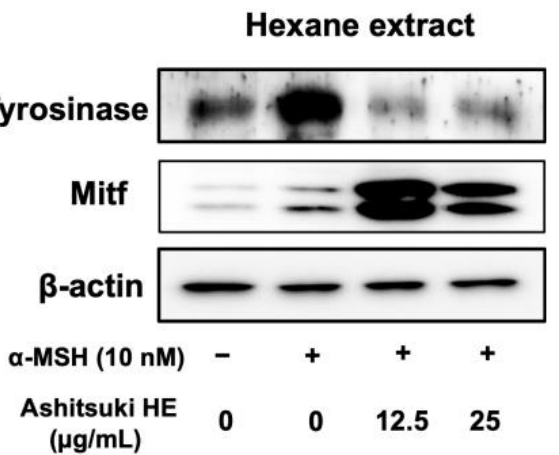
Mitf protein level was upregulated by the N. verrucosum extract treatment.